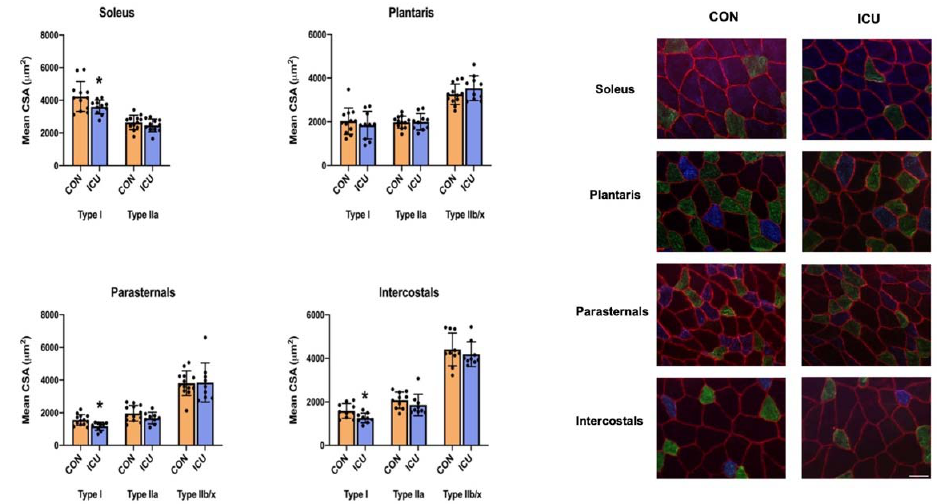
Figure 8. Muscle fiber cross-sectional area. Cross-sectional area of fiber types of the soleus, plantaris, parasternal, and intercostal muscles of control, non-anesthetized, non-ventilated rats (CON), and rats that underwent 12 h of controlled mechanical ventilation (ICU). Data are presented as mean ± SEM. * significantly different vs. CON ( p < 0.05).